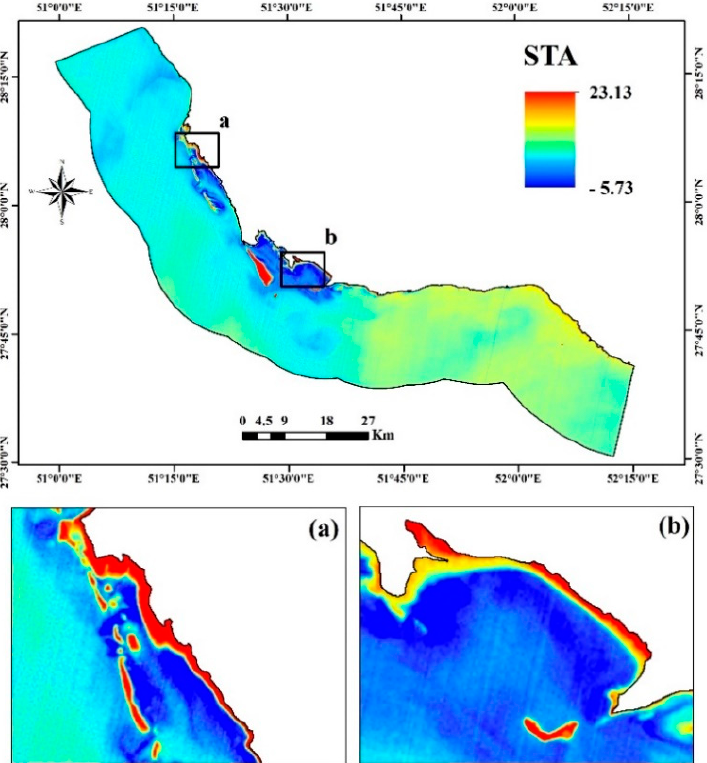
Figure 4. An example of the STA (standardized thermal anomaly) map of the study area on 23 August 2015 (9:45 a.m. local time): ( a ) Shif-Hendijan and ( b ) Naiband #1.